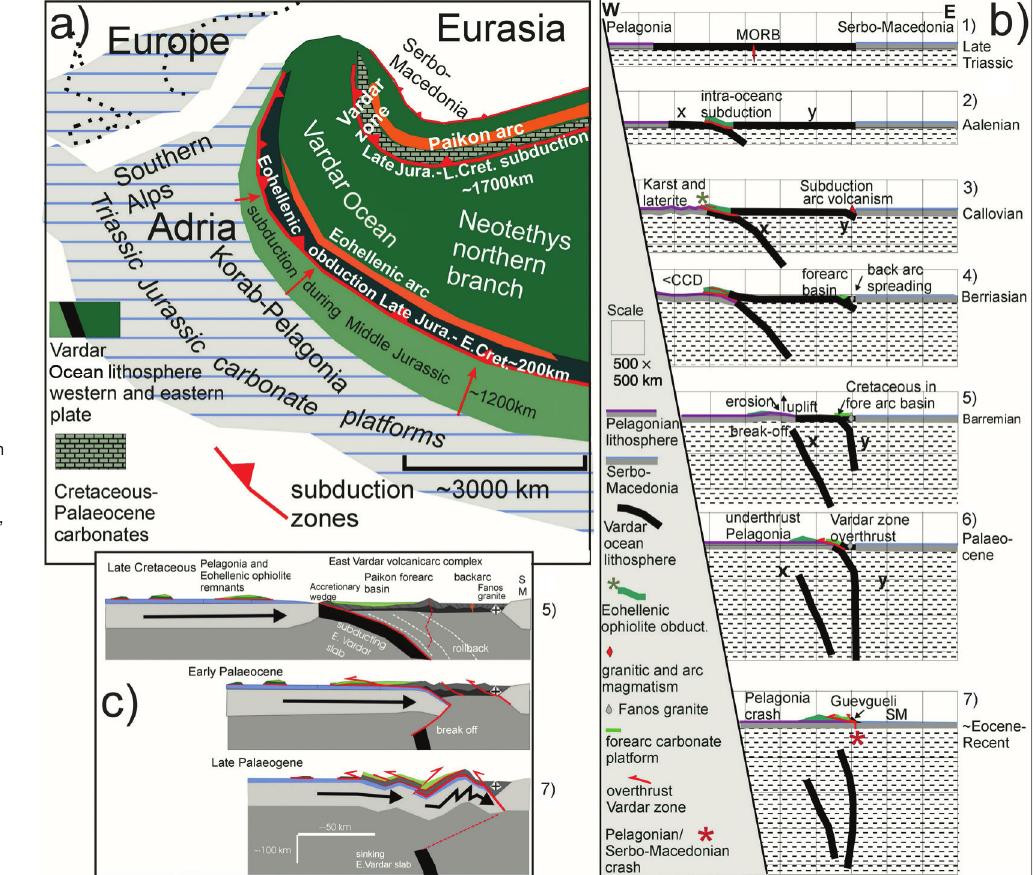
Paleogeography and time-lapse cartoons. a) The Vardar Ocean was situated between two passive margins, continental Adria (including